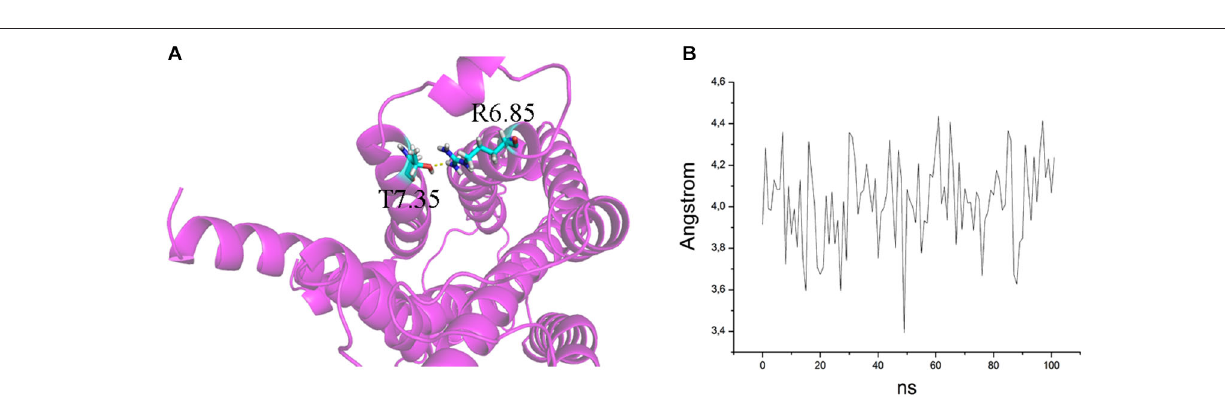
FIGURE 6 | (A) H bond between T7.35 and R6.58 in the mutant E7.35T. The backbone is shown in cartoon representation and the residues are indicated in stick format. (B) Distance between the oxygen atom of T7.35 and hydrogen aminic atom of R6.58 measured over the MD